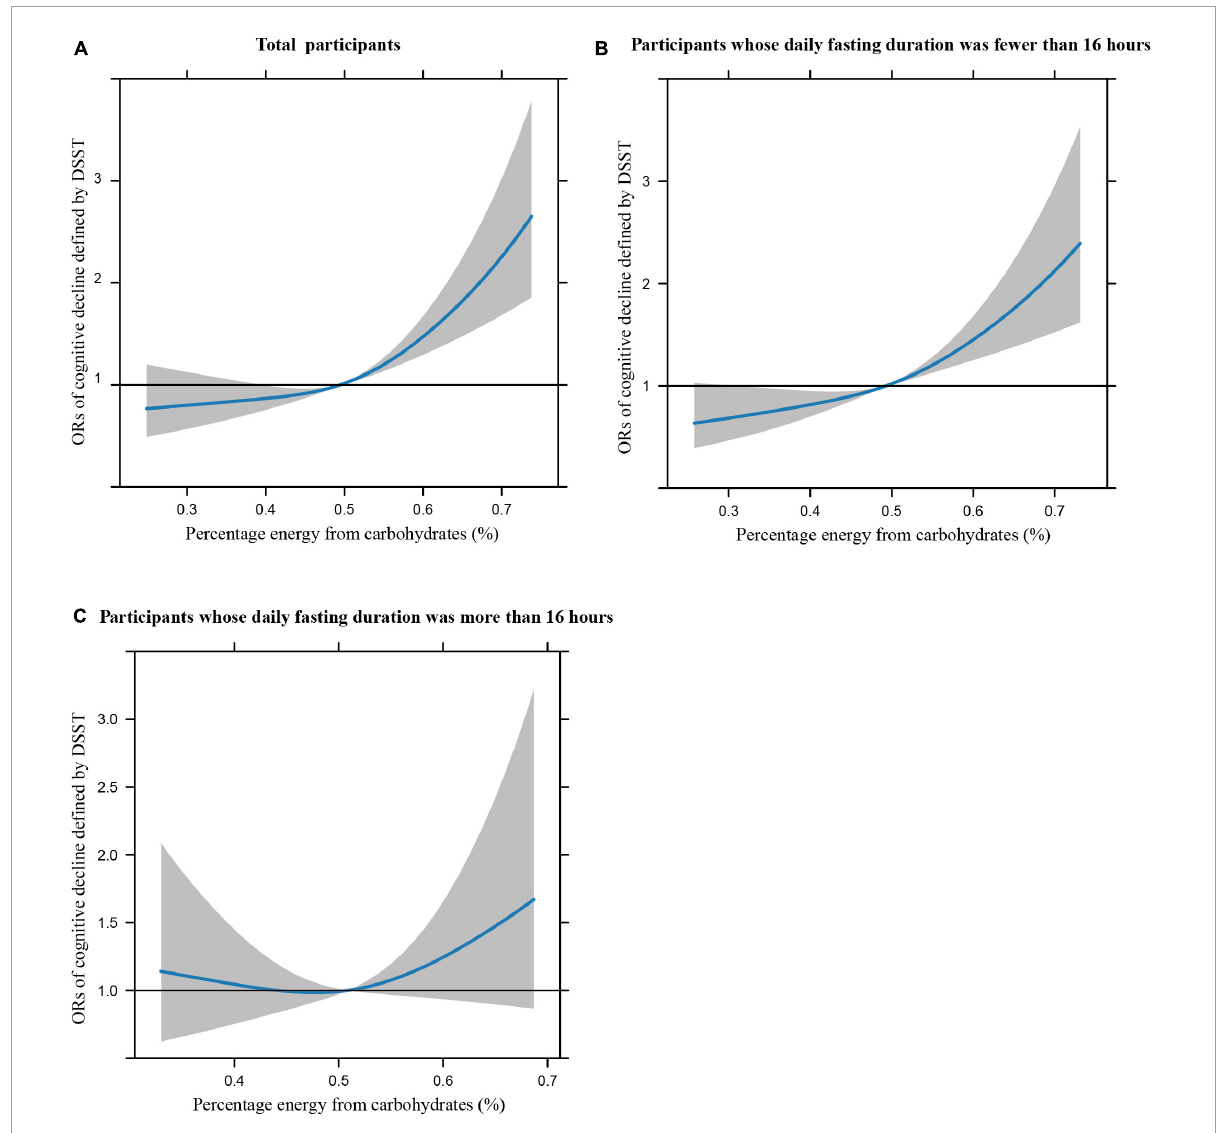
FIGURE1 Restricted cubic splines between percentage energy from carbohydrates (%) and poor cognitive performance of